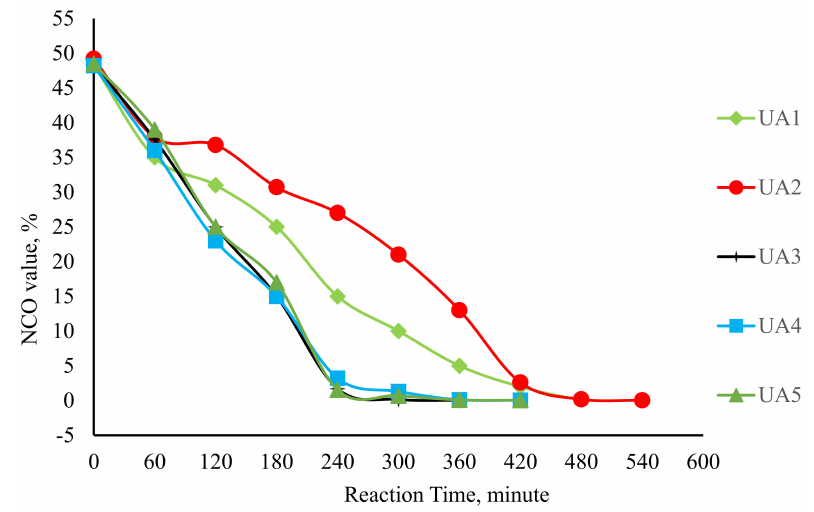
Figure 4. The NCO values during the synthesis of the PFAD urethane acrylate.